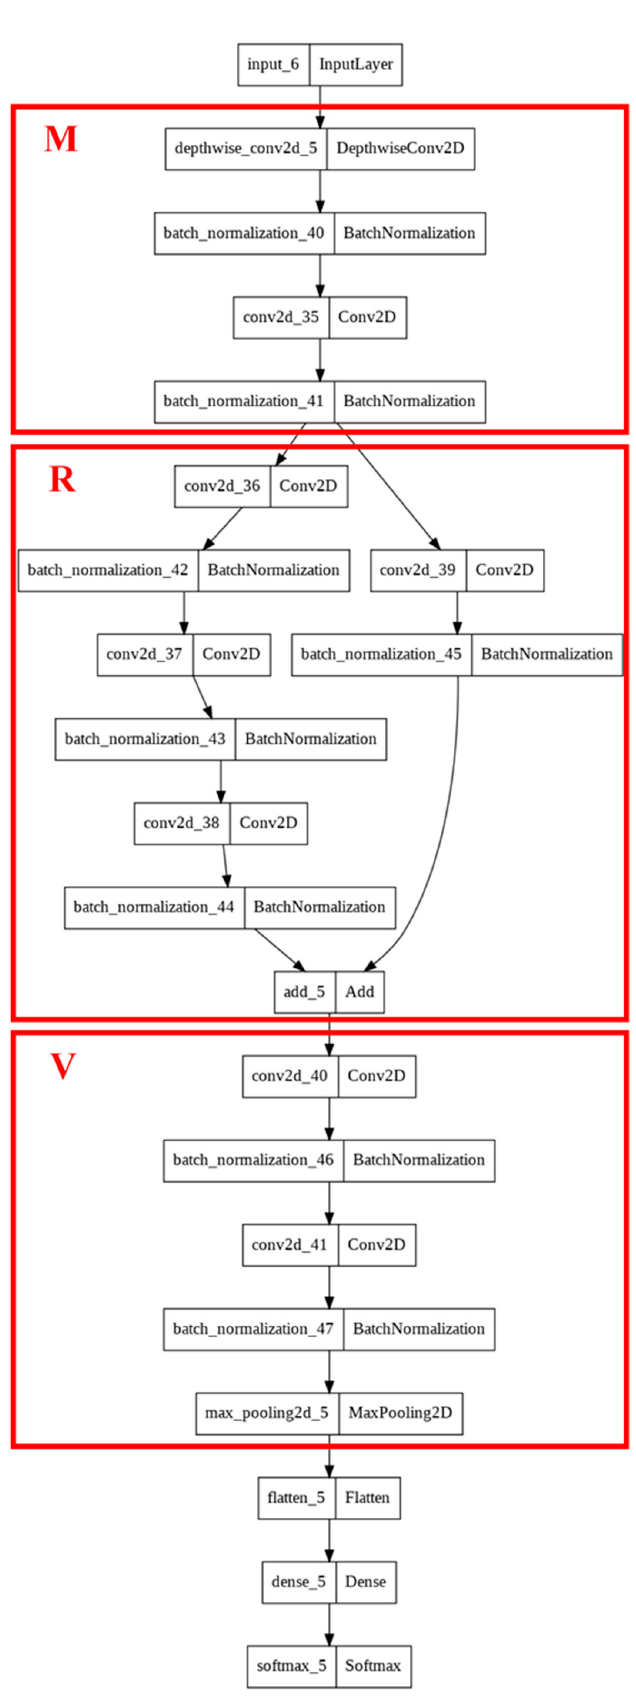
Figure 14. Structure of the designed AutoML model based on MRV.